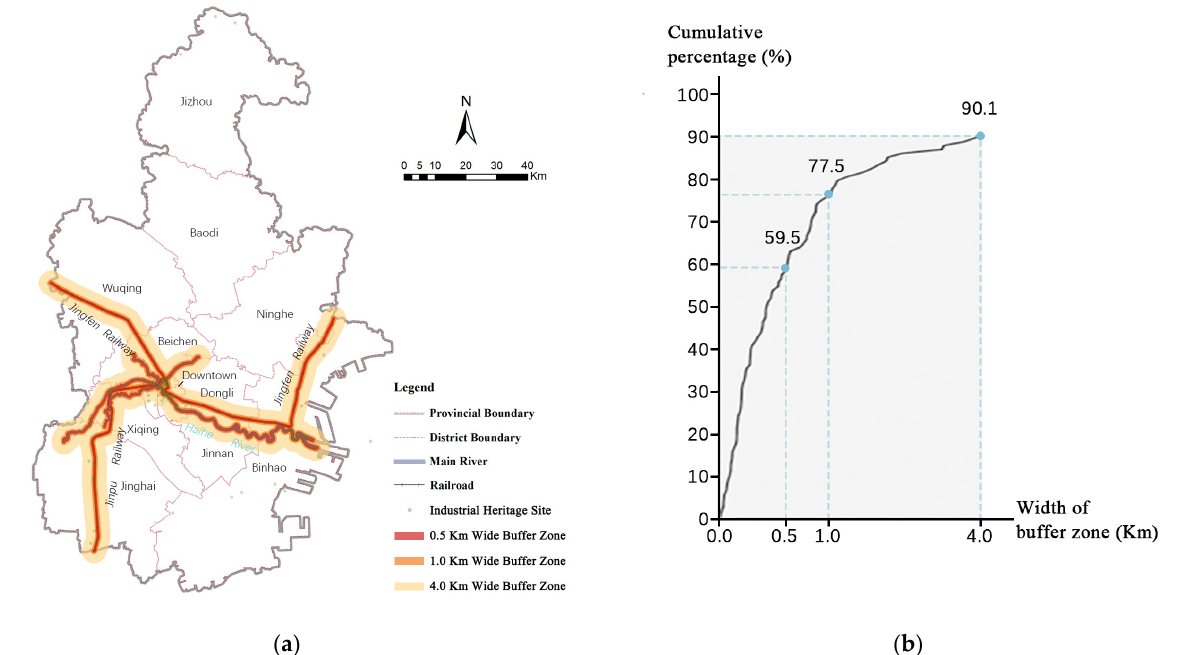
Figure 5. ( a ) Map of the Tianjin Industrial Heritage Buffer Zone; ( b ) cumulative percentage of industrial heritage within buffer zones of different widths in Tianjin.